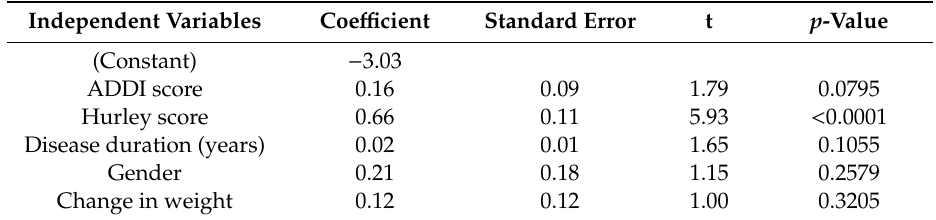
Figure 4. Change in the IHS4 score before (T 0 ) and after (T 1 ) Ramadan broken down according to the treatment received. Table 1. Multivariate regression analysis investigating co-variates associated with change in the IHS4 score.